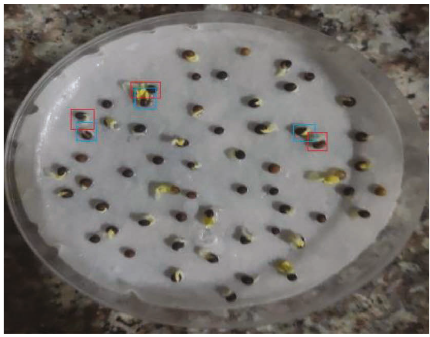
Figure 7: Densely distributed seed